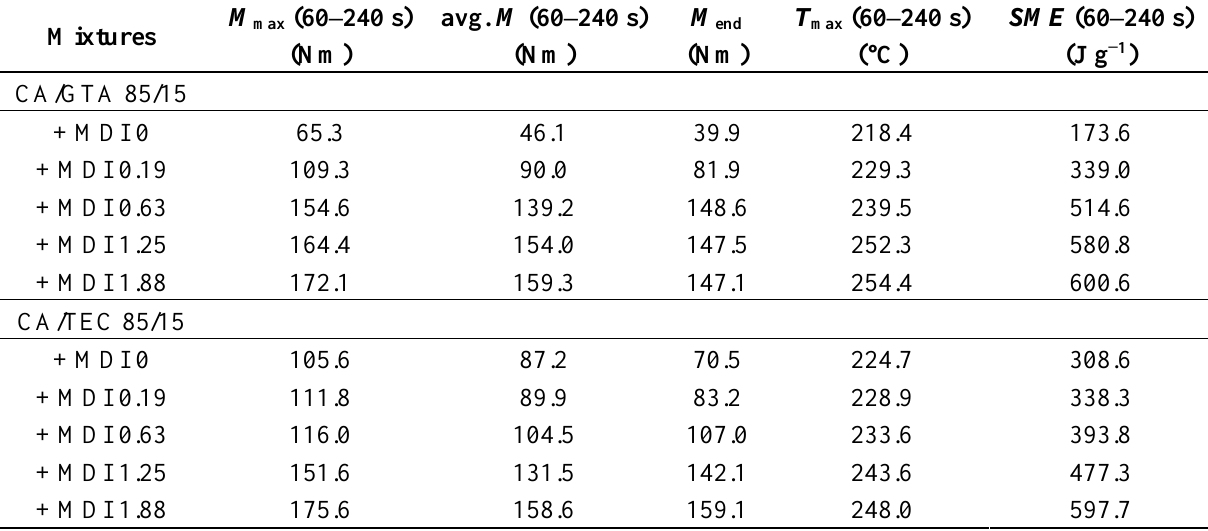
Table 2. Characteristic melt mixing data during homogenization step (60–240 s) for CA/GTA/MDI and CA/TEC/MDI. avg. means